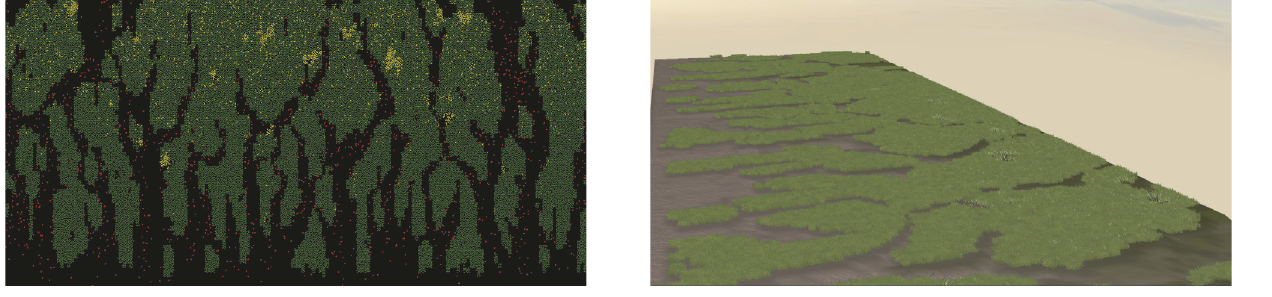
Figure 16: Global overview of the virtual ecological model